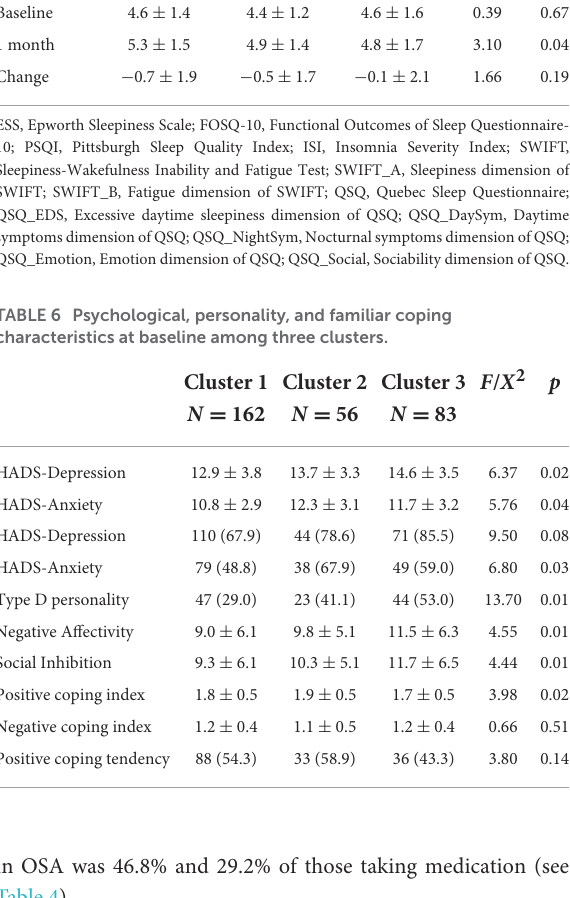
Subjective severity of OSA measured by self-reported ESS, ISI, SWIFT, and PSQI as well as OSA-related quality of life measured by FOSQ-10 and QSQ were assessed to explore sleep- related health issues across multiple groups. The longitudinal patterns of adherence were closely related to the degree of daytime sleepiness and daytime function in patients with OSA. The SWIFT scores were significantly increased in cluster 2, and the sleepiness dimensions of the QSQ were decreased in cluster 2, indicating that patients in cluster 2 had a higher level of sleepiness. For the SWIFT, the self-reported scores of “improvers” were significantly higher (12.1 ± 7.0)